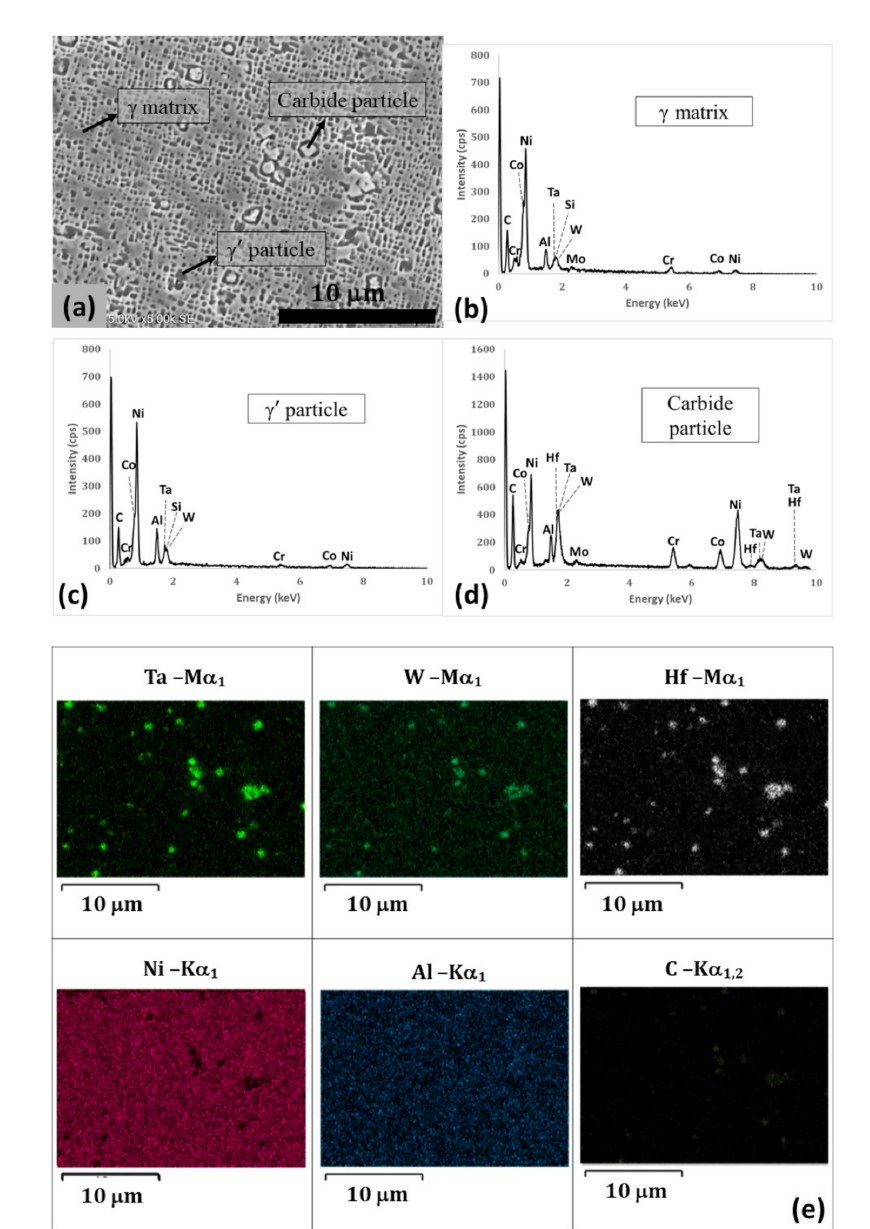
Figure 9. ( a ) The 4275M72 deposits produced from the powder blend after PFHT depicting precipita- tion of γ ’ phase and Ta-Hf-W-based carbides in the γ -matrix, ( b – d ) EDS spectra of phases indicated in panel ( a ), and ( e ) EDS elemental maps of carbides in panel ( a ). Tensile testing was performed on the aged samples since this alloy is a precipitate hardened alloy and practically should be used only after aging post-weld heat treatment. Table 5 shows the tensile properties of LDEDed 4275M72 from room temperature up to 1366 K (1093 ◦ C). The strength of 4275M72 was superior to R80 (see Table 1) in almost the entire test temperature range. At room temperature, the ultimate tensile strength (UTS) and yield strength of 4275M72 were 26% and 22% higher than those of R80, respectively, when it demonstrated 50% higher ductility. However, at elevated temperatures R80 possessed higher ductility compared to